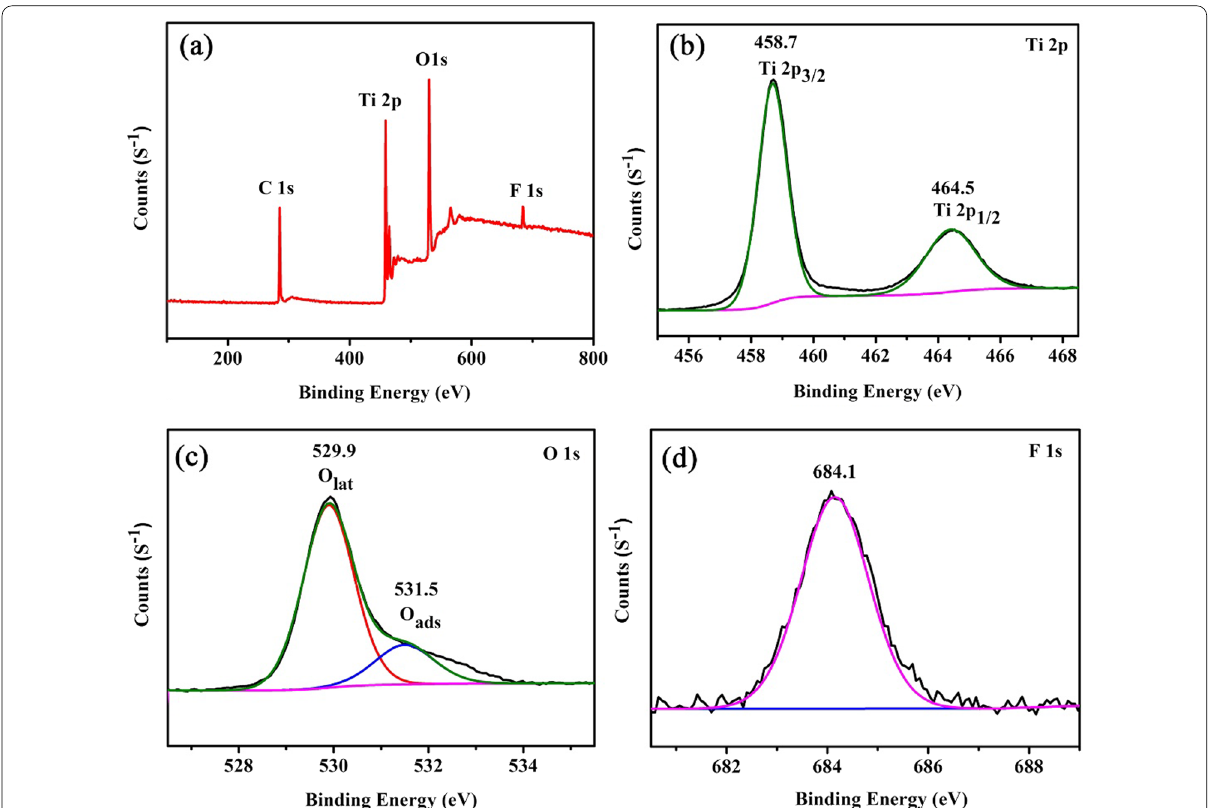
Fig. 4 XPS analysis of TiO2 FLNMs: a the full XPS spectrum, b Ti 2 p spectrum, c O1 s spectrum, d F 1 s